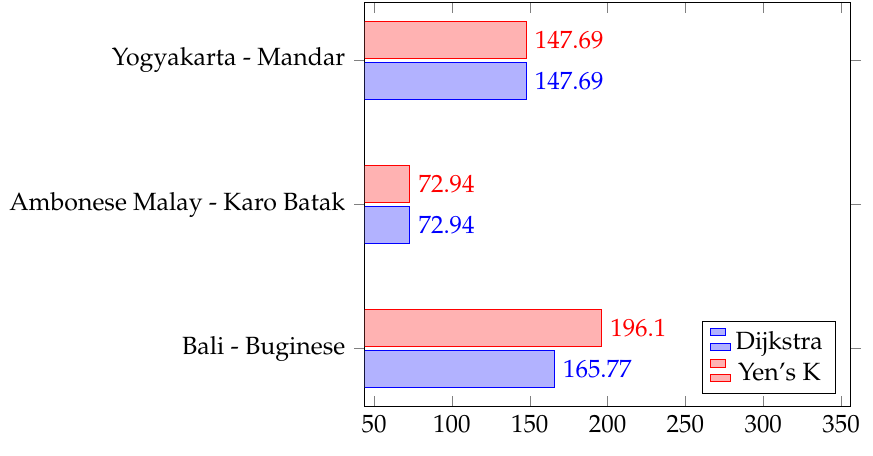
Figure 4. Performance comparison by total cost